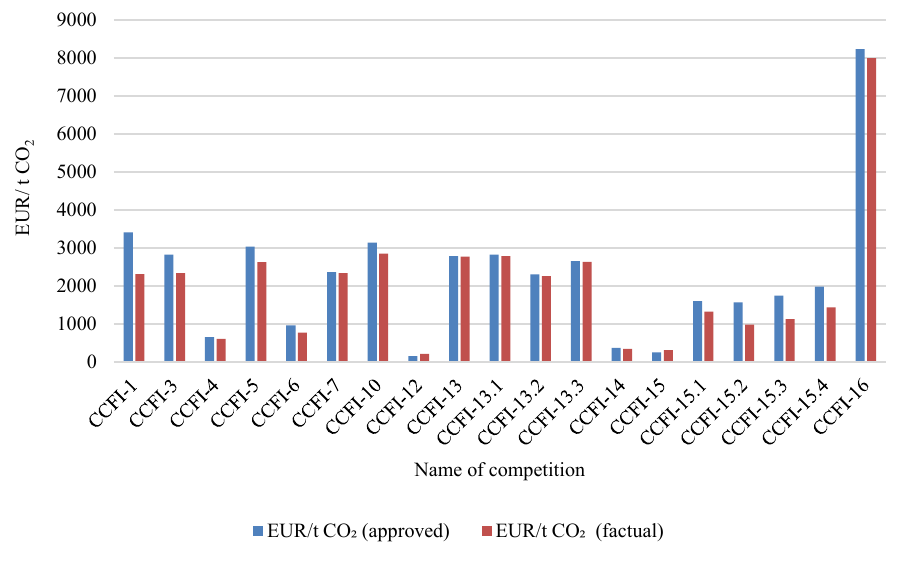
Fig. 3. Average costs of one CO 2 tonne